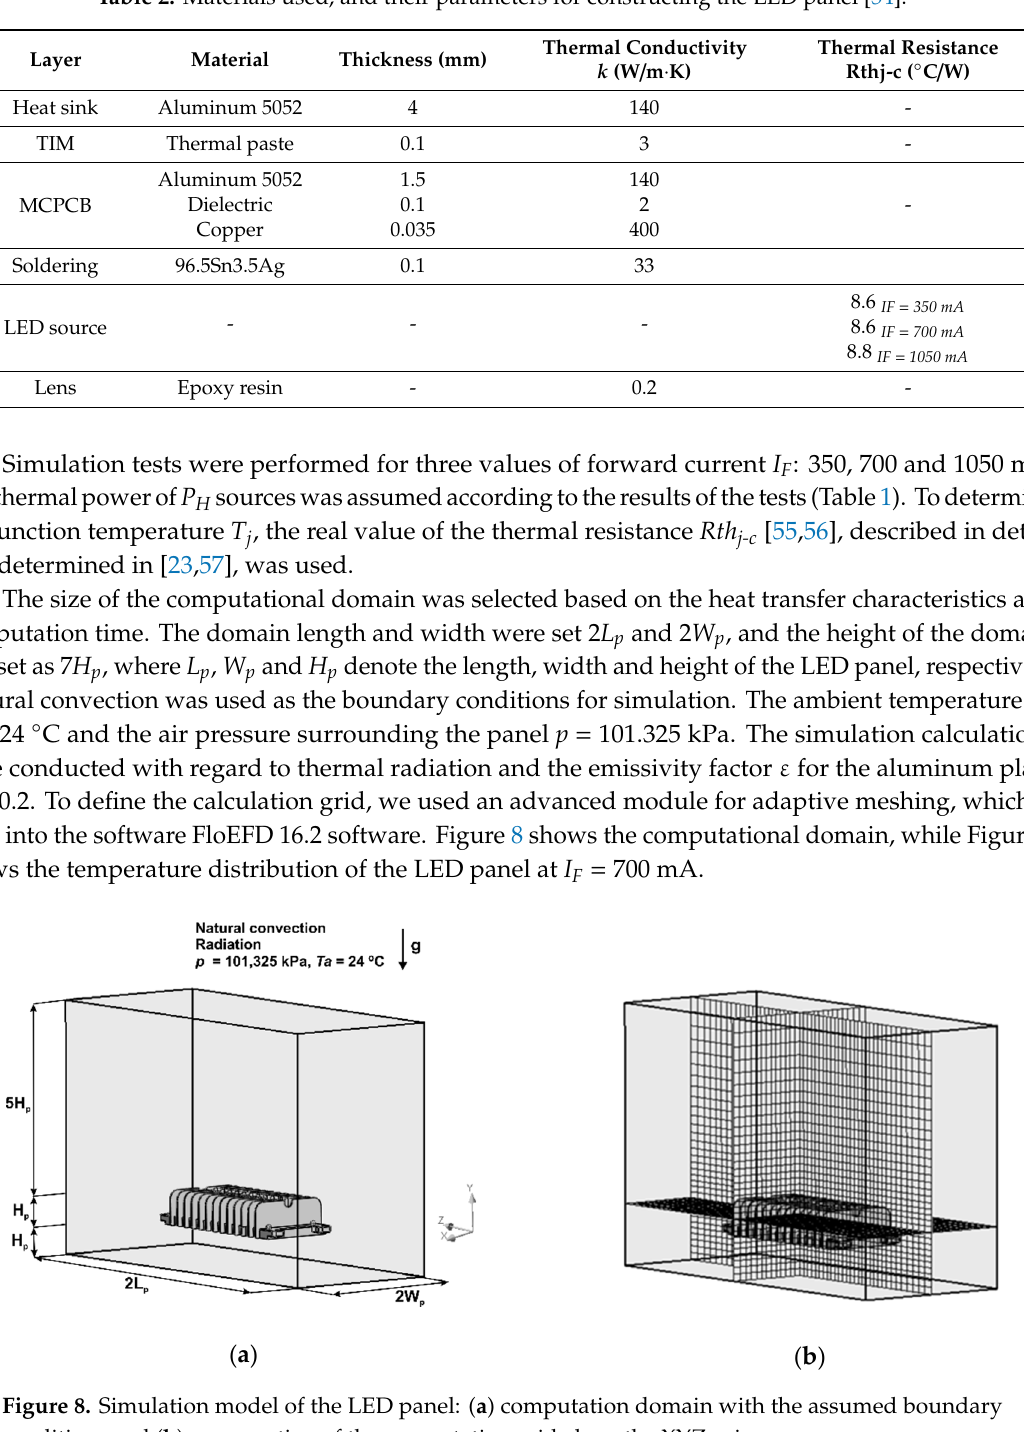
Table 2. Materials used, and their parameters for constructing the LED panel [54].